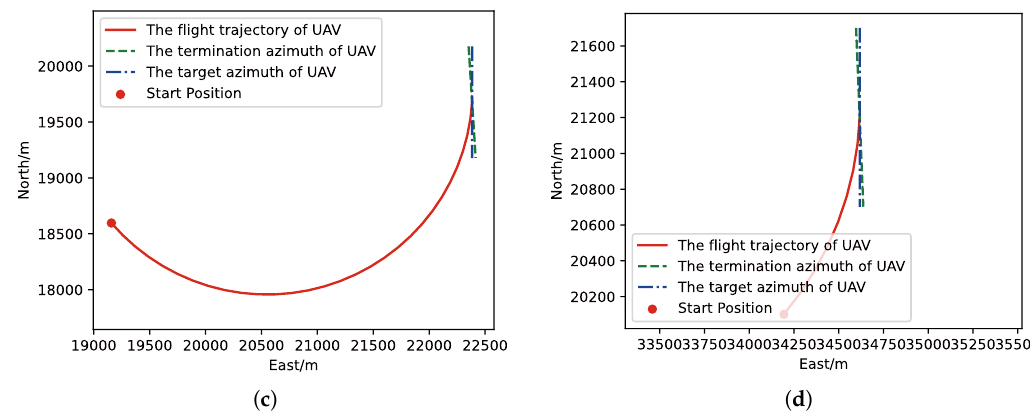
Figure 12. The flight trajectory from MC experiments for the trained result of PER-DDPG: ( a ) the flight trajectory of 1st experiment; ( b ) the flight trajectory of 2nd experiment; ( c ) the flight trajectory of 3rd experiment; ( d ) the flight trajectory of 4th experiment.